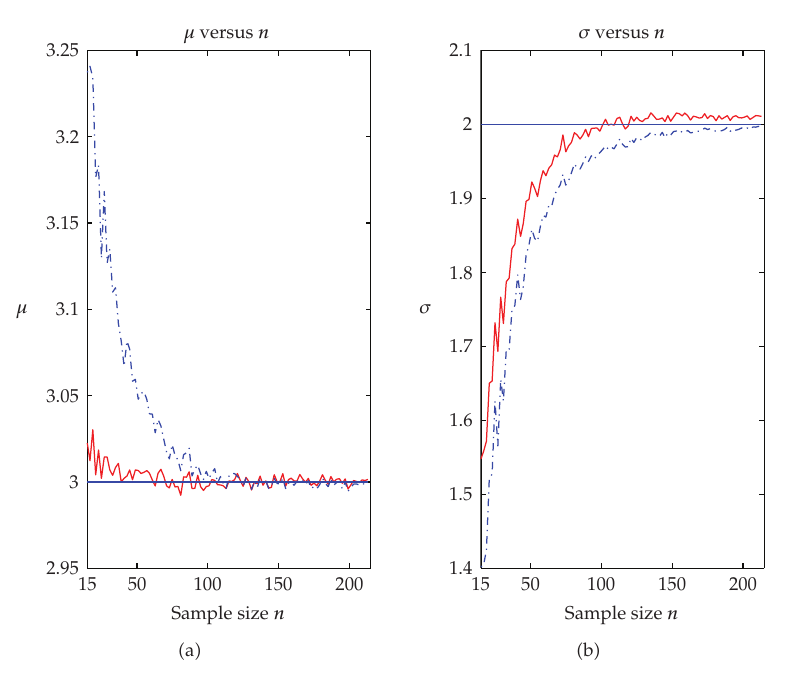
Figure 1: Grouped data: τ 1 (cid:8) 2, τ 2 (cid:8) 2 . 5, τ 3 (cid:8) 3, τ 4 (cid:8) 3 . 5, τ 5 (cid:8) 4. Type I left censored data: τ (cid:8) 2